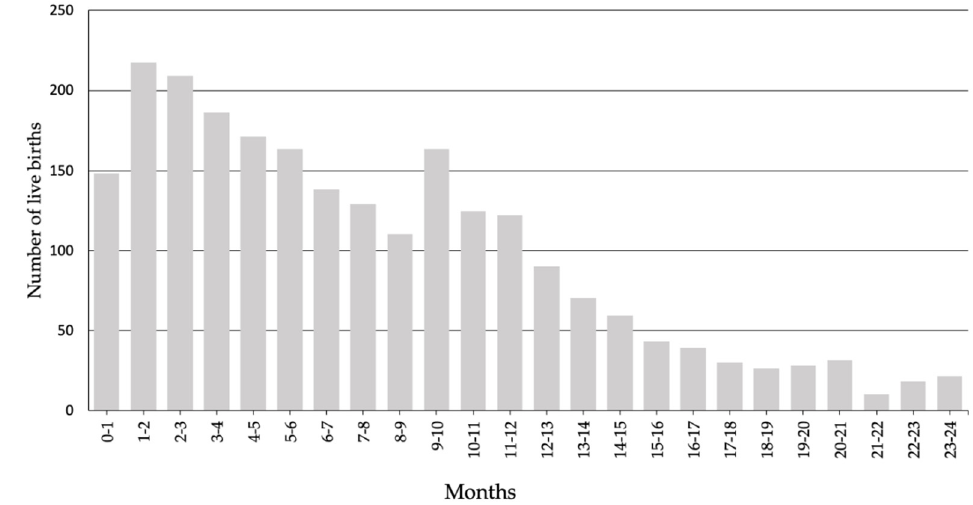
Figure 2. Distribution of live births by the mothers’ length of stay in an ASC before giving birth (from 0–24 months).